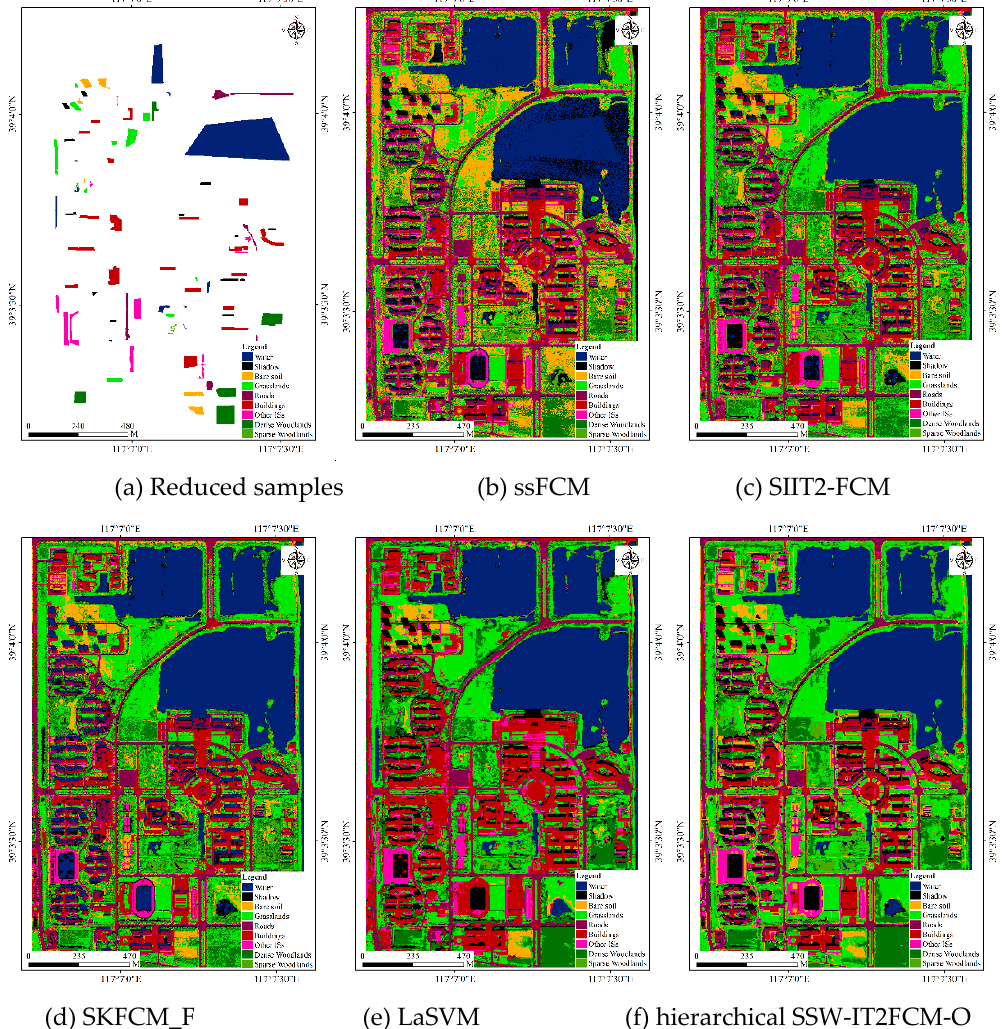
Figure 14. The banded spectral curves of true value and spectral curves modeled by hierarchical SSW- IT2FCM-O (wavelength: nm). The x-axis is the wavelength, and the y-axis represents the reflectance for a scale factor of 10,000.